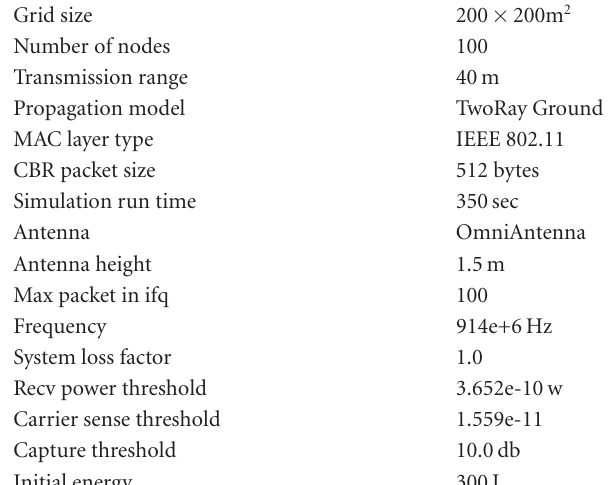
Table 1: Simulation